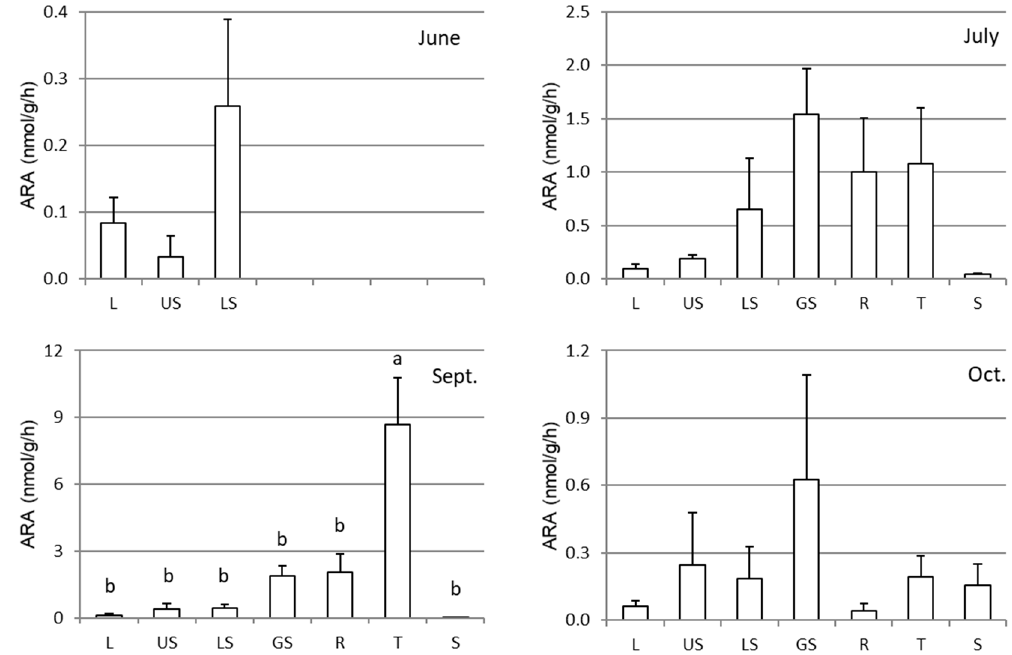
Figure 3. Acetylene reduction activities (ARA) in different parts of sweet potatoes (Sa-B) cultivated in an experimental field from seedling-stage (June) to harvest (October). L, US, LS, GS, R, T, and S represent the leaf, upper stem, lower stem, underground stem, root, tuber, and rhizosphere soil, respectively. The error bars indicate standard errors ( n = 5), and different letters indicate significant differences at P < 0.05 by Tukey’s test.